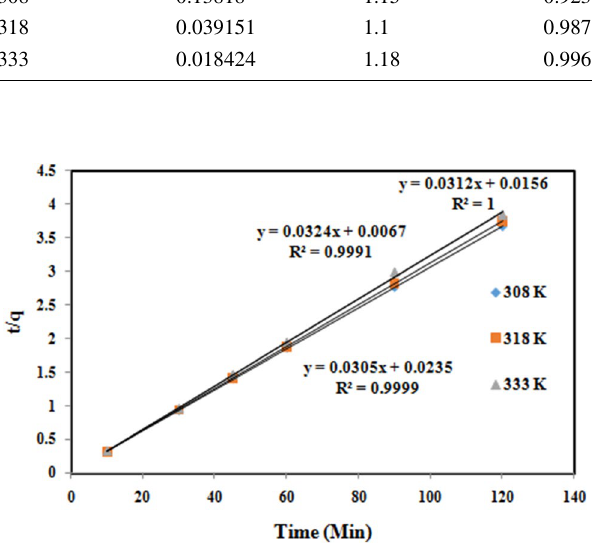
Fig. 14 Pseudo second order reaction kinetics for adsorption of MG (NLP: 3 g/l, MG: 100 mg/l, pH: